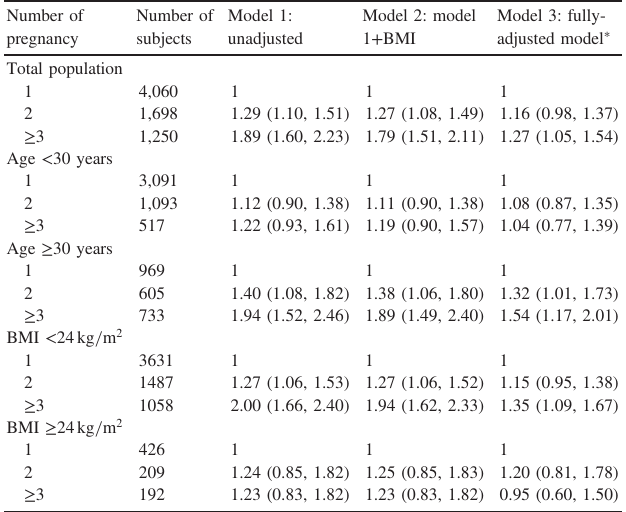
Figure 1. Prevalence of gestational diabetes in di ff erent age and pre-pregnancy body mass index groups according to number of pregnancies. * The adjusted covariates included age, pre-pregnancy BMI, education, annual household income, smoking status, drinking status and passive smoking exposure. Table 2. Odd Ratios and 95% con fi dence intervals for GDM according to number of